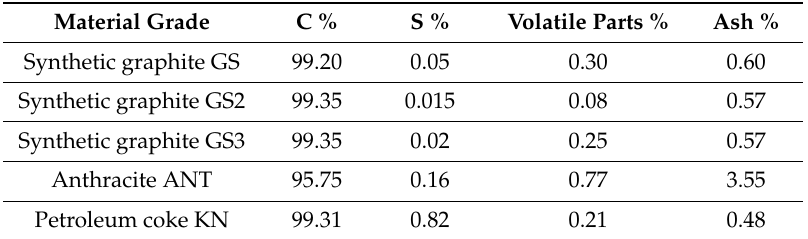
Table 1. The chemical composition of the carburisers.